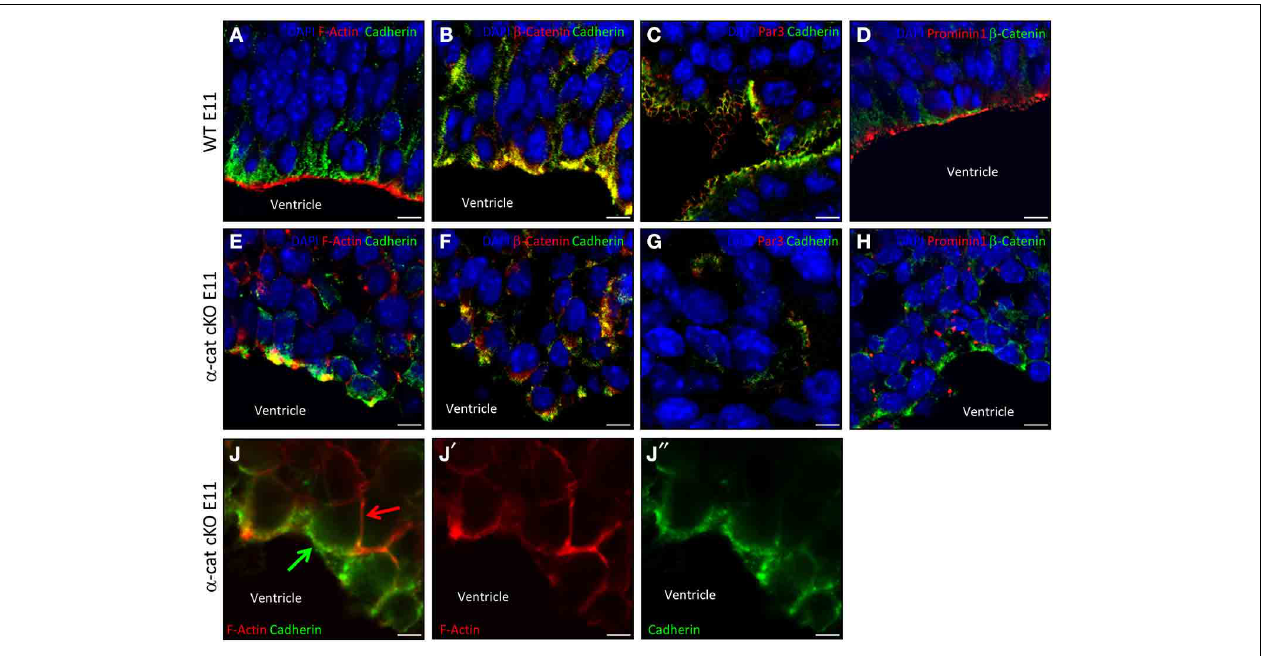
FIGURE 6 | Adhesion and polarity upon loss of α -catenin. Fluorescence micrographs of coronal cortical sections of E11 WT (A–D) and α -cat cKO (E–J) immunostained as indicated. Arrows